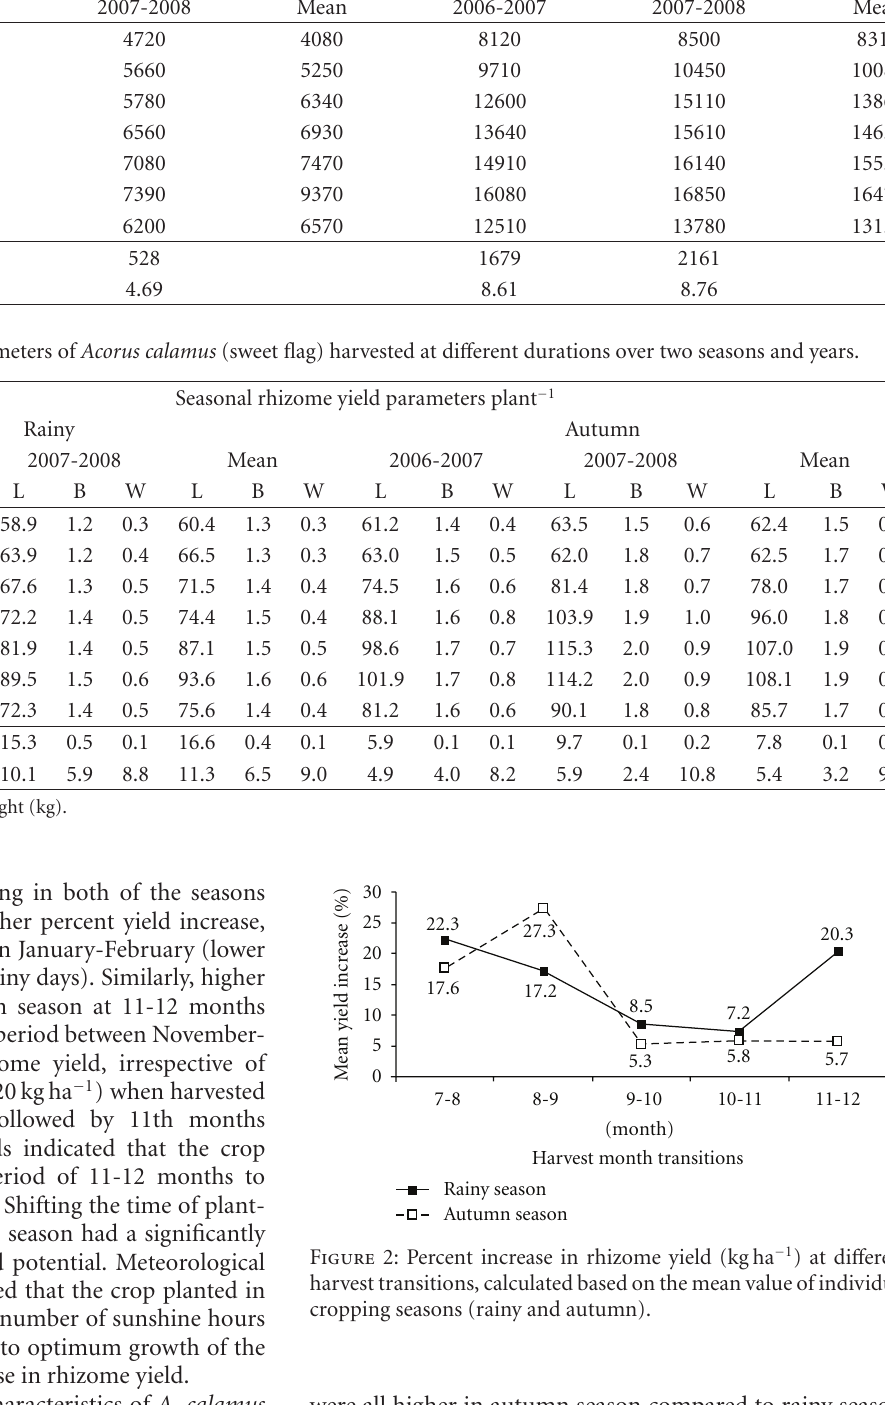
Table 2: Rhizome yield of Acorus calamus (sweet flag) harvested at di ff erent durations over two seasons and years. Harvest time